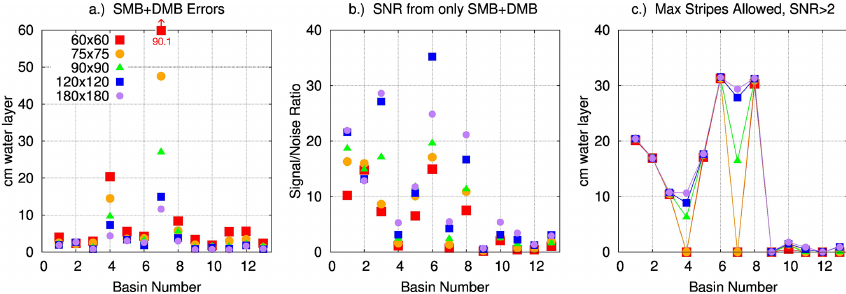
Figure 10. (a) Estimated errors caused by misfits between the SMB and DMB input data and the defined basin weights, (b) signal-to-noise ratio using only the misfit errors, and (c) the maximum stripe level allowable to result in a SNR >2 when stripes are included. All figures use yearly windowed data.